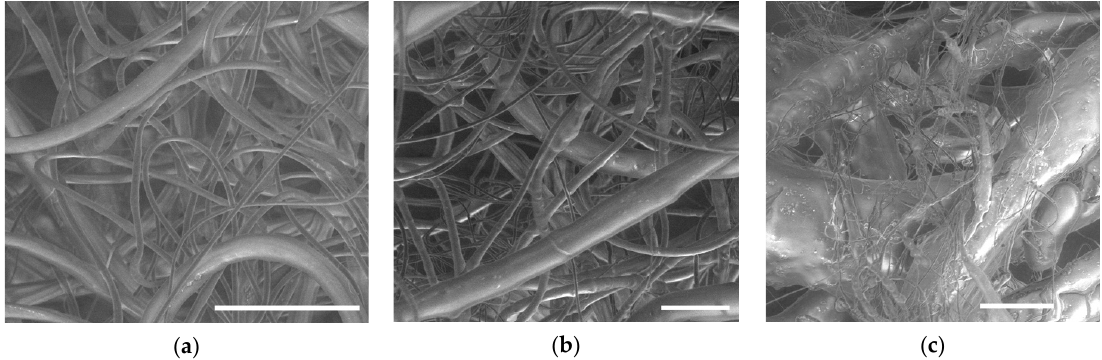
Figure 3. Micrographs of the nonwoven materials: PP+SS ( a ), (90PP+10CC)+SS ( b ), (50PP+50CC)+SS ( c ). Scale bar is 40 µ m.